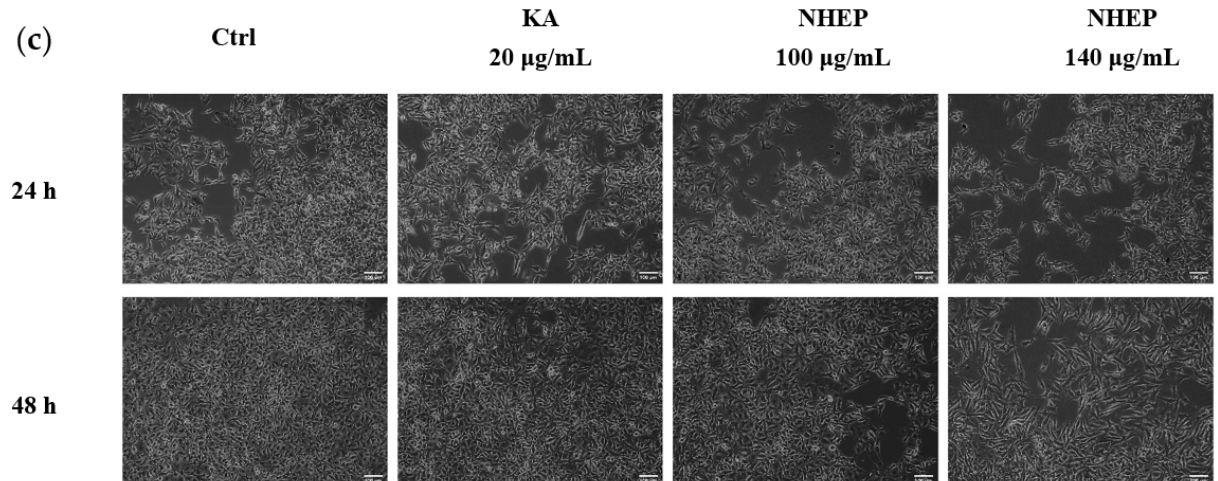
Figure 11. Cytotoxicity of NHEP on B16 cells: ( a ) viability of the B16 cells cultured with the NHEP for 24 h, ( b ) viability of the B16 cells cultured with the NHEP for 48 h, ( c ) cellular morphology of the B16 cells cultured with the NHEP for 24 h and 48 h (scale bar is 100 µ m). Significance: compared with the control group, ** p < 0.01, *** p < 0.0001. The data shows as the mean ± S.D. ( n = 5). KA stands for Kojic acid, and the concentration is 20 µ g/mL.